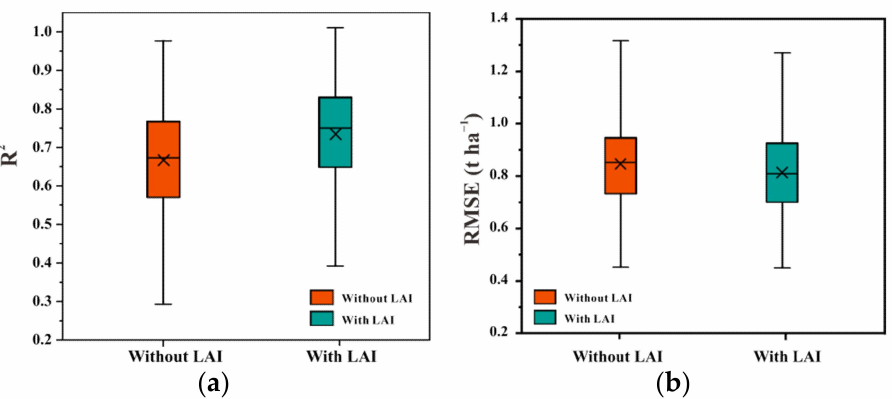
Figure 6. The statistical distributions of prediction accuracy of the stacking regression when including four growth stages for predicting grain yield in the test phases; ( a ) distributions of R 2 without or with LAI coupling; ( b ) distributions of RMSE without or with LAI coupling.